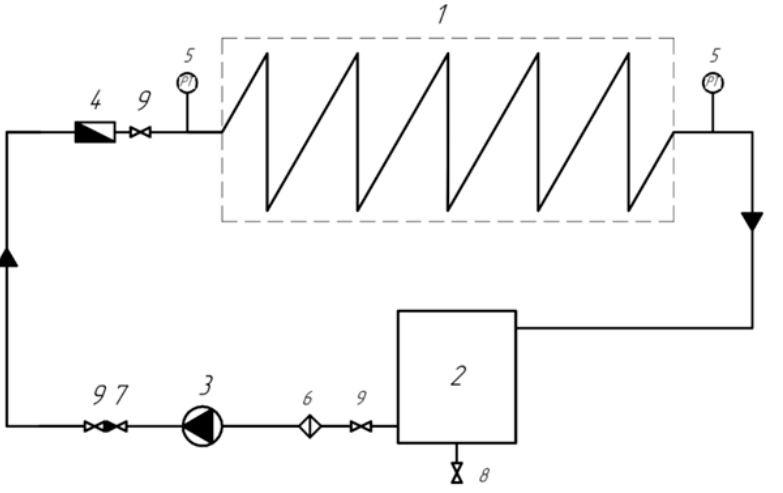
Figure 4. Diagram of the hydraulic system of the laboratory stand: 1—coil; 2—feed water tank; 3—pump; 4—flow meter; 5—pressure sensor; 6—sump filter; 7—check valve; 8—drain ball valve; and 9—ball